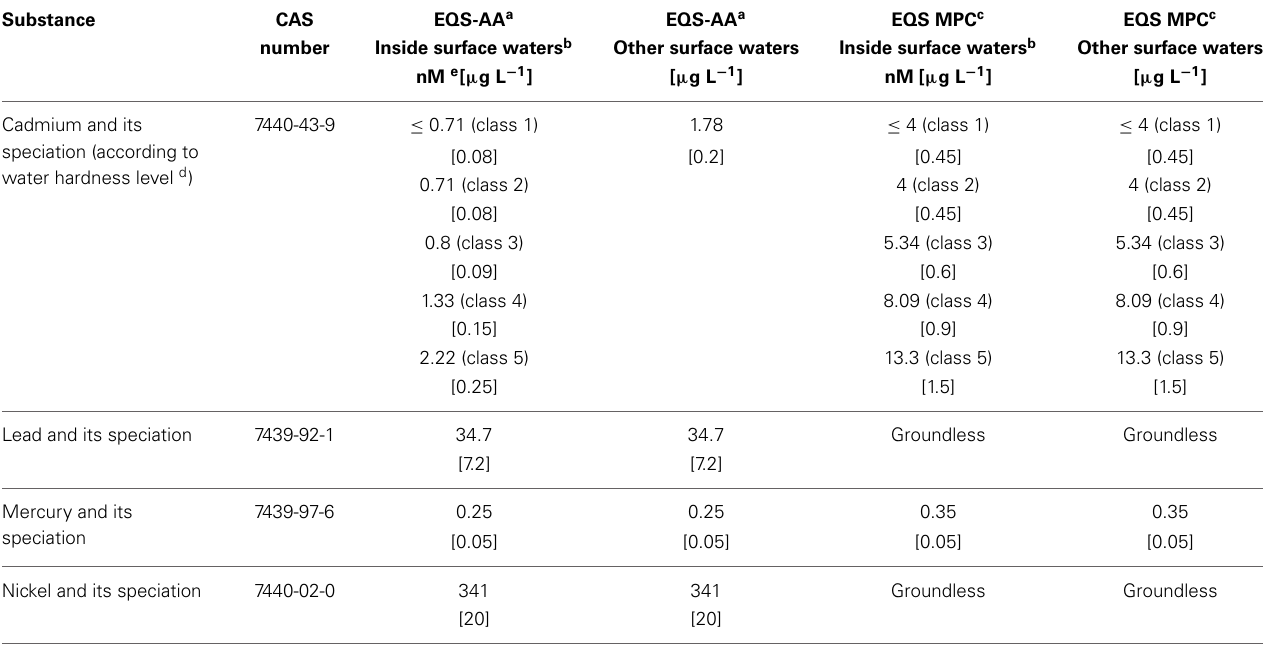
Table 1 | Environmental Quality Standards for heavy metals (also called WFD).